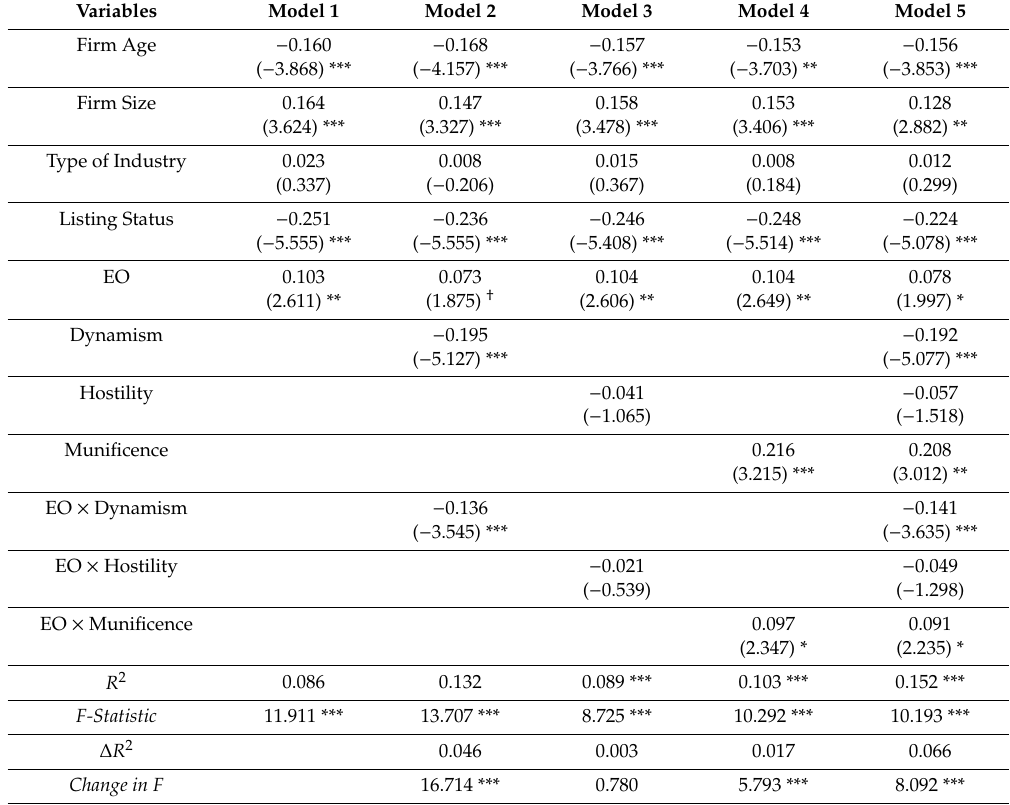
Table 3. The results of hierarchical regression analysis (N = 337) a